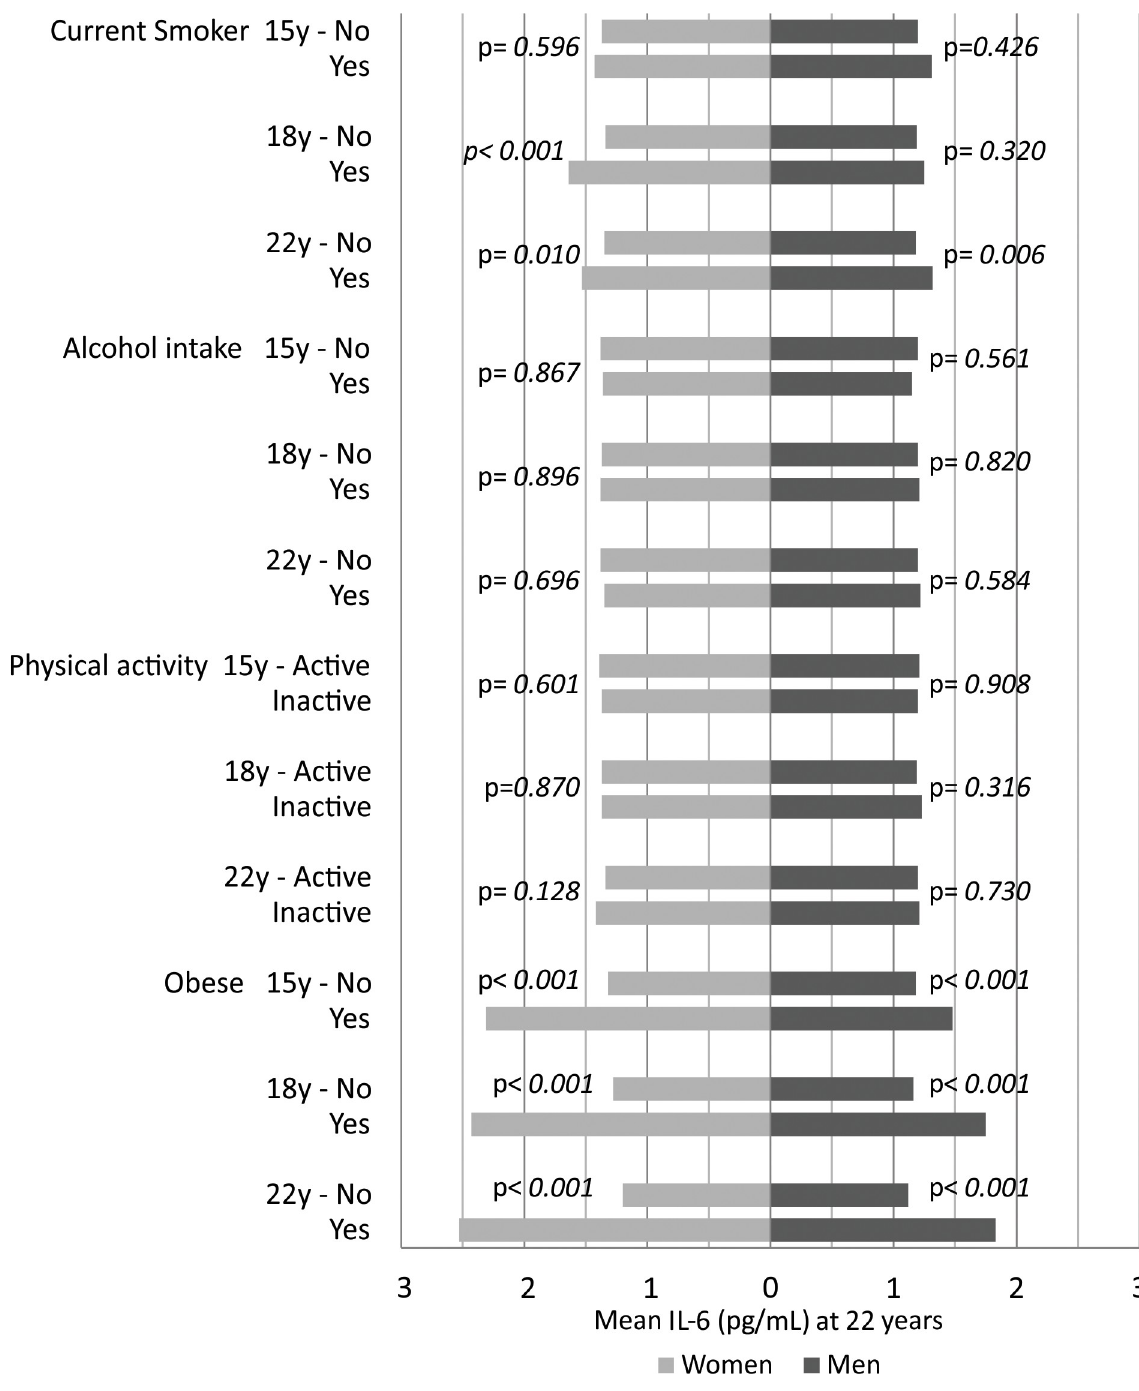
Fig 2. Mean levels of Interleukin-6 (IL-6) at 22 year follow-up according to smoking, alcohol intake, physical activity and obesity at 15, 18 and 22 years. The 1993 Pelotas Birth